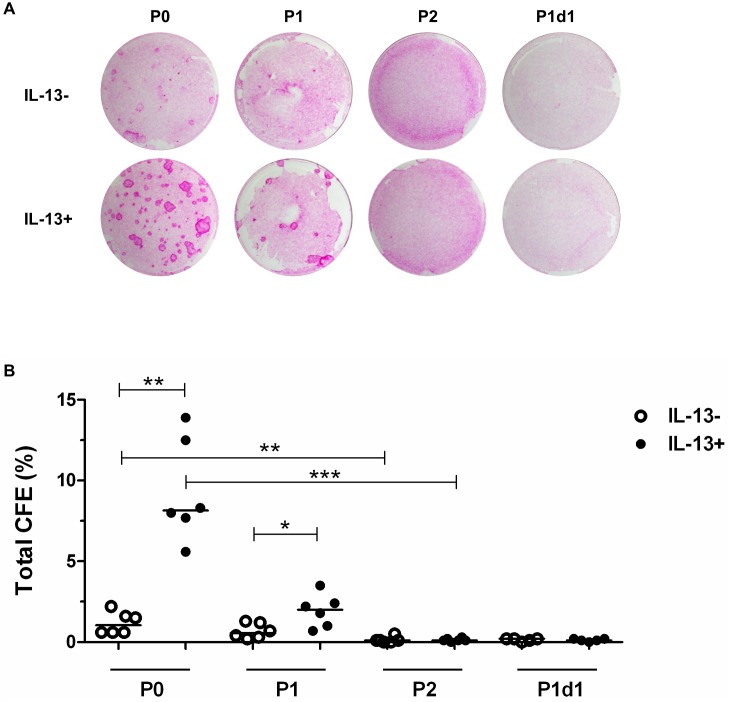
Comparison of total CFE.At the end of cultivation, P0 cells from limbal explants, P1 and P2 cells, and the unattached GC-enriched subpopulation (P1d1, harvested on day 1 after passage of primary cells) were cultured with growth-arrested 3T3 mouse fibroblasts to compare their growth ability under IL-13- and IL-13+ conditions. All total CFE data are presented in vertical scatter plot graphs with line indicating median. *P < 0.05, **P ≤ 0.01, ***P ≤ 0.001. (A) Colonies grown in CFE assay and stained with 2% rhodamine B (day 12). (B) Distribution of total CFE percentages of the P0, P1, P2, and P1d1 groups.